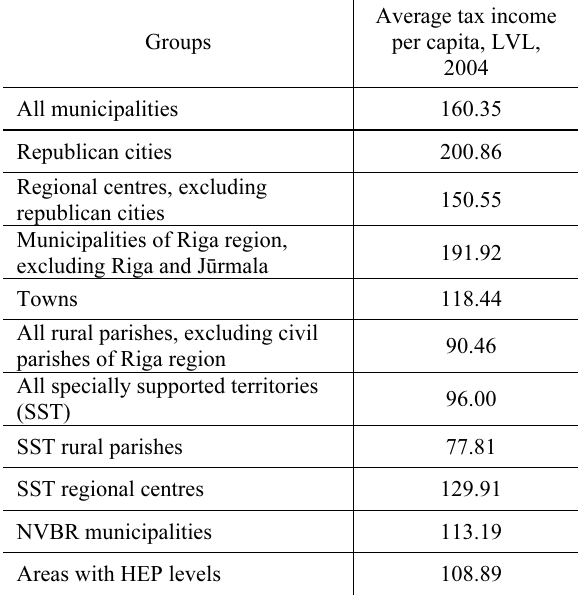
Table 4. Average tax income per capita in LVL, 2004